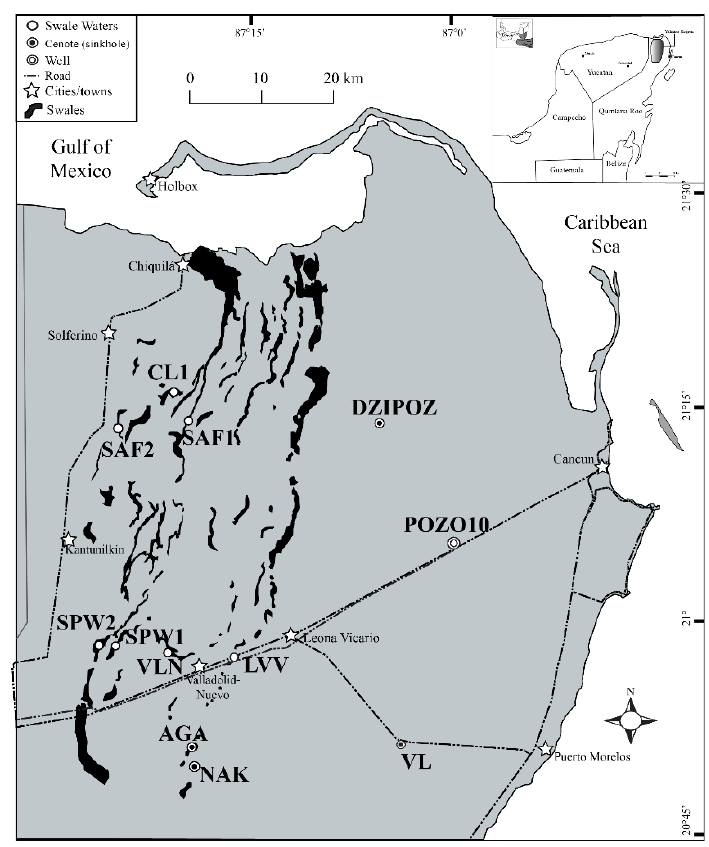
Figure 1. Yalahau region site map showing sampling points.